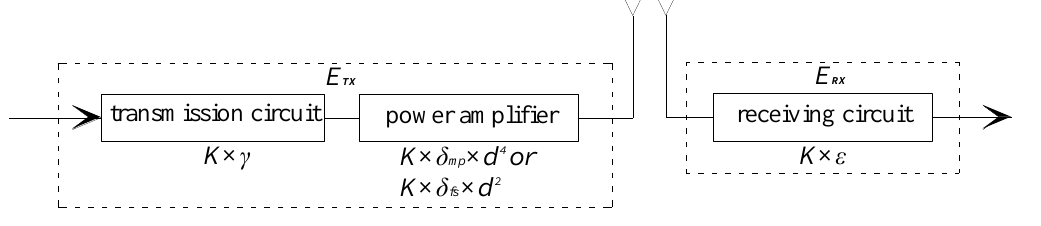
Figure 2. The first-order wireless communication mode.